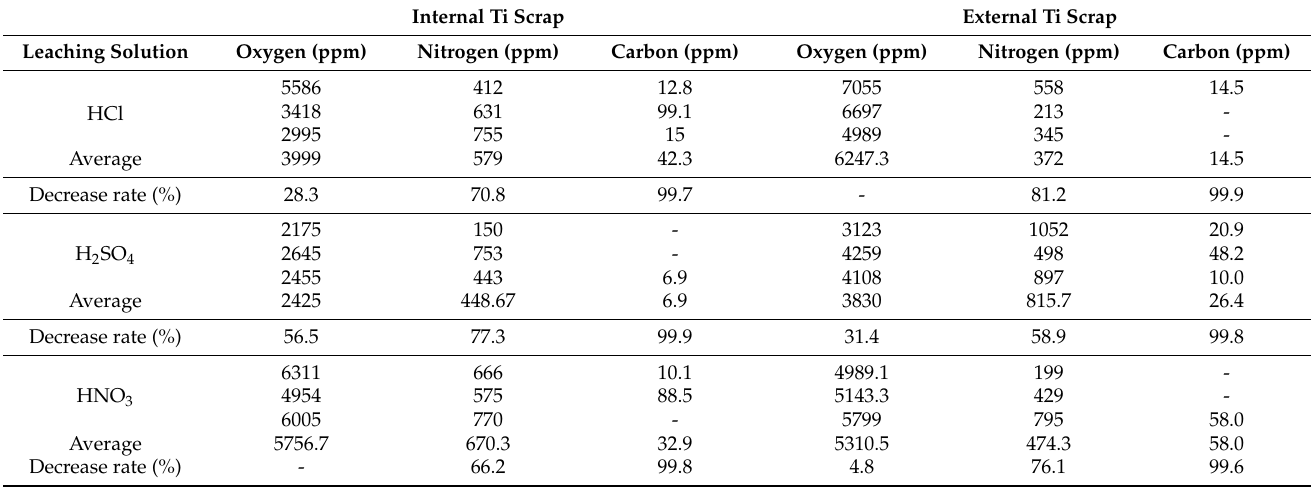
Table 2. Ti scrap component analysis after being subjected to deoxidation with various leaching